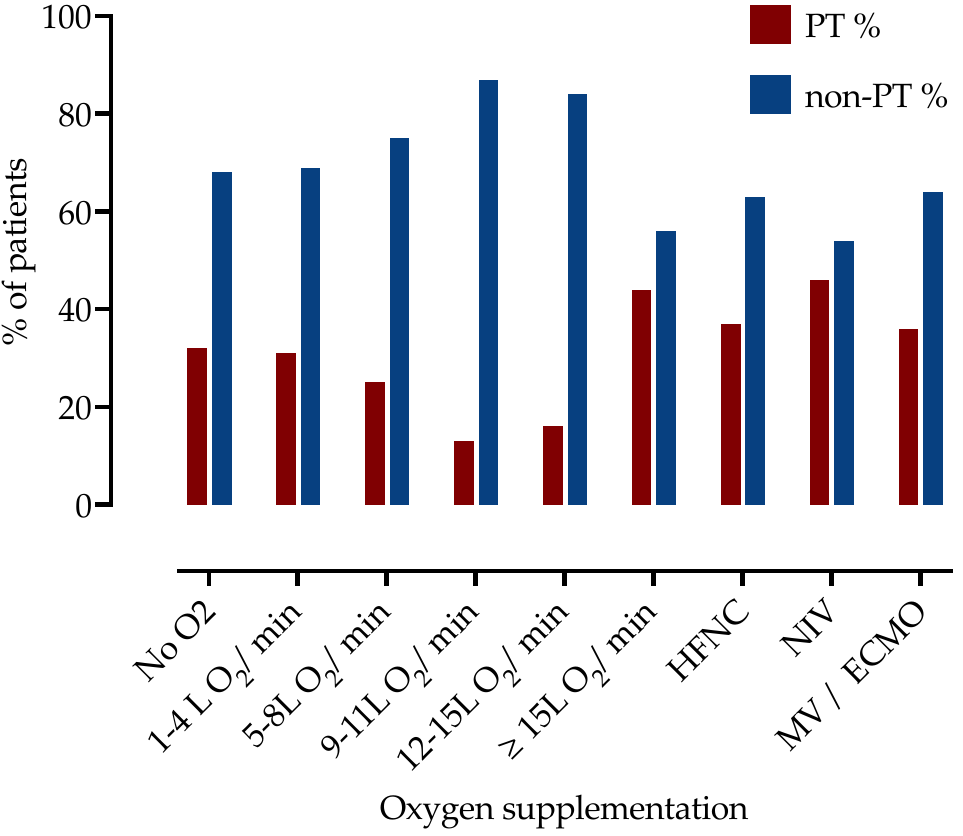
Figure 1. Frequency of patients with PT stratified by the respiratory support level. PT—pulmonary thrombosis, HFNC—high flow nasal cannula, NIV—non-invasive ventilation, IMV—invasive me- chanic ventilation, ECMO—extracorporeal membrane oxygenation.